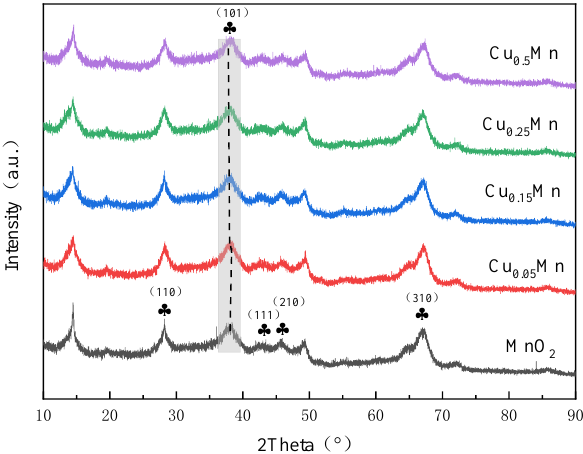
Figure 1. XRD curves of Cu-doped MnO 2 catalysts. The SEM photos of Cu-doped MnO 2 catalysts can be seen in Figure 2. As can be seen from the scan image magnified 5000 times, the pure MnO 2 and Cu-doped MnO 2 both showed similar morphologies, with rough and uneven surfaces, and a part of the larger particle loaded, which could easily fall off due to collision and friction in the later stage [33]. After comparative analysis, small particulate matter appeared on the original MnO 2 /γ-Al 2 O 3 pattern after copper doping. As can be seen from the scanning figure magnified 20,000 times, in the pore structure of the γ-Al 2 O 3 particles, Cu entered the pore in the form of small pellets and honeycomb and was loaded well inside. Because MnO 2 is doped into the γ-Al 2 O 3 support, it is judged that the gray area is alumina and the white area is MnO 2 . Most of the MnO 2 (white) was embedded in γ-Al 2 O 3 (gray) as particles. The surface structure of the support did not change greatly after loading.